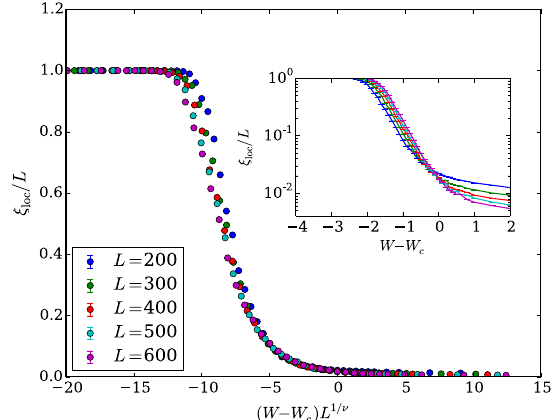
FIG. 5. Finite-size scaling for the disorder-averaged localiza- tion length ξ (see Fig. 2) using a simplified model that ignores loc the renormalization of the couplings. Results are averaged over ∼ 10 4 disorder realizations.